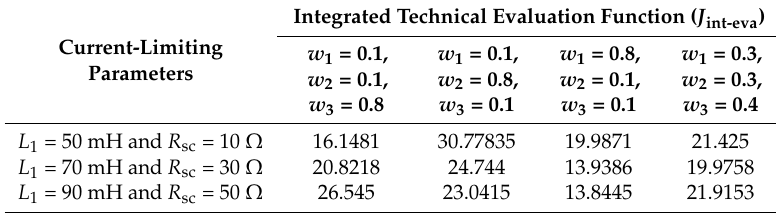
Table 5. Calculation results of the integrated technical evaluation function under different weighting factors (internal